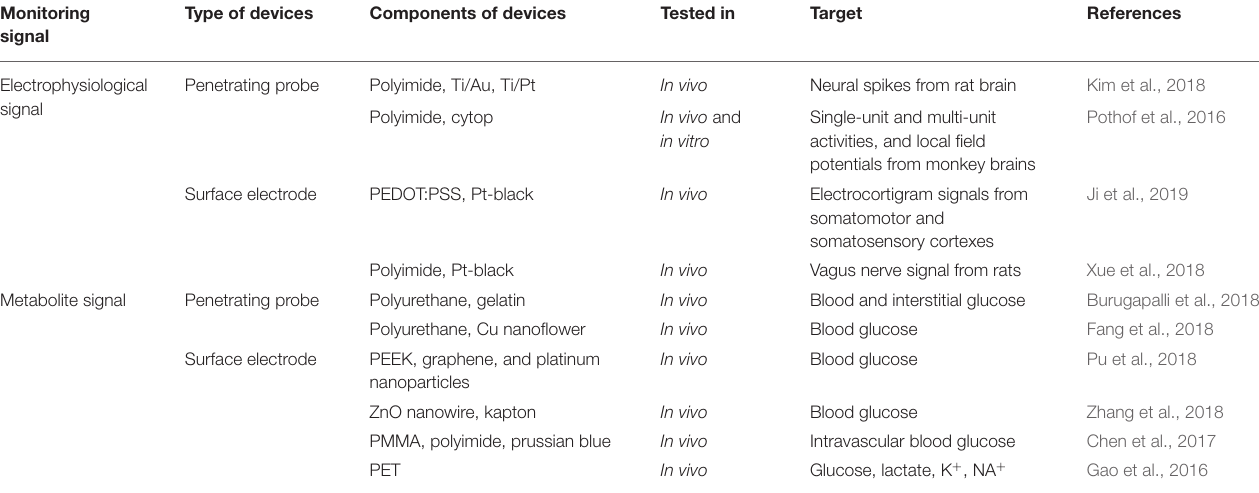
TABLE 1 | Flexible electronic devices for the monitoring of electrophysiological and metabolite signals. Monitoring